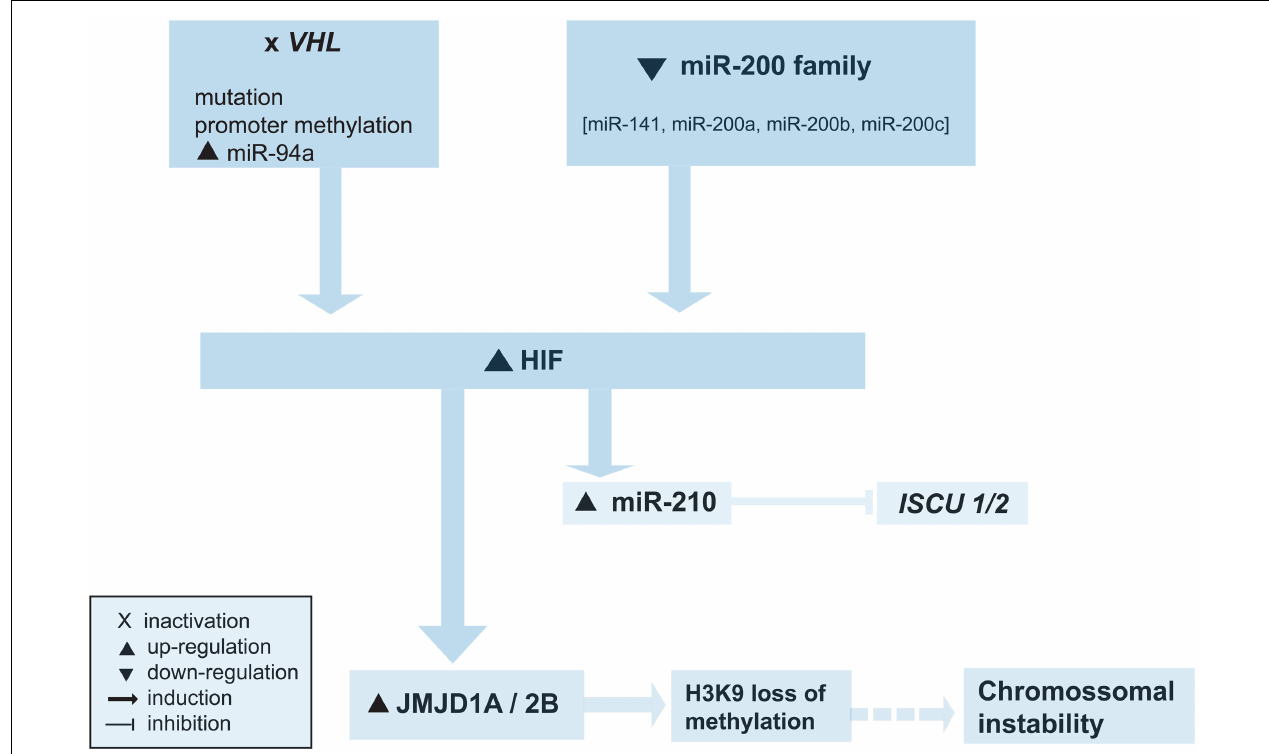
FIGURE 1 | Overview of the epigenetic alterations involved in abnormal hypoxic cellular response. See text for